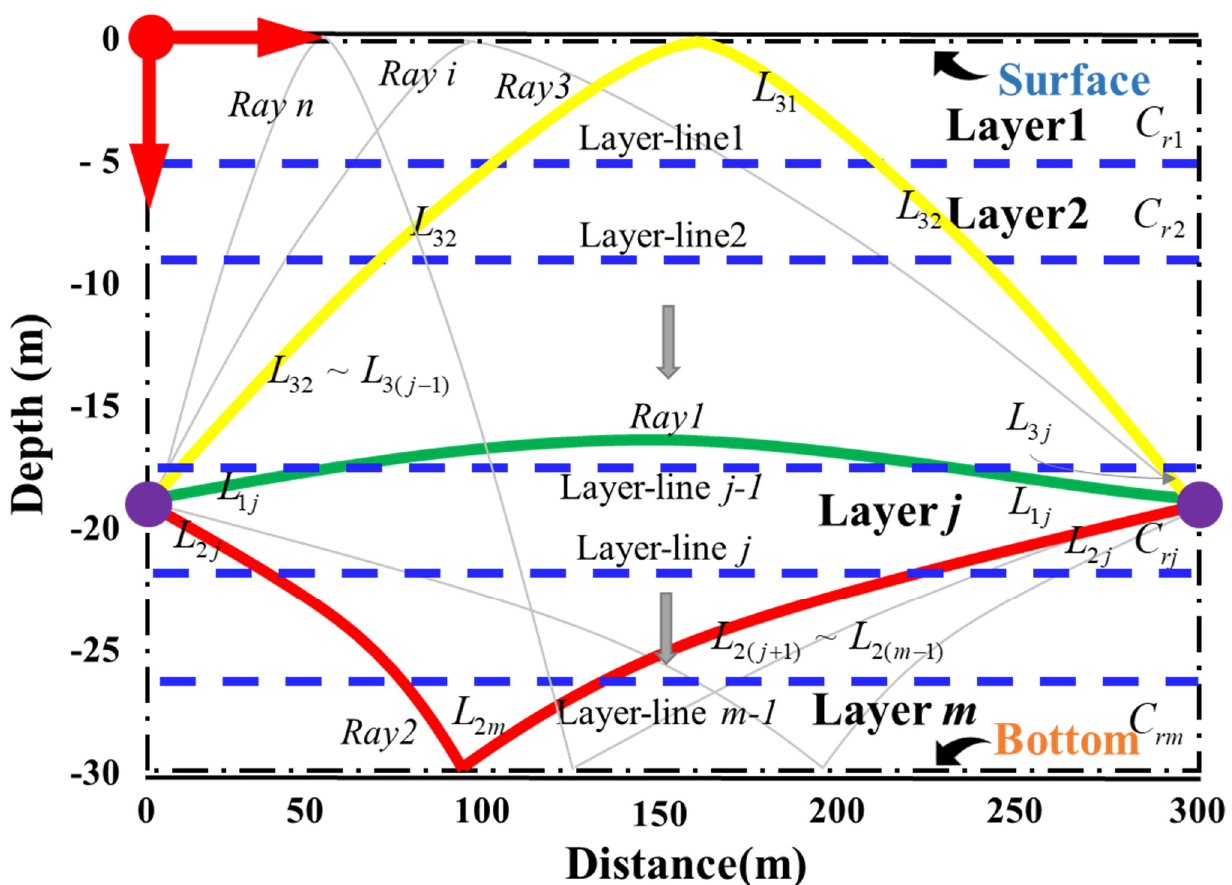
Figure 1. Reference ray simulation. L ij denotes the ray length of the i -th ray across the j -th layer. C rj denotes the reference acoustic speed of the j -th layer. The yellow line (Ray3) indicates a surface reflected ray. The green line (Ray1) indicates a direct ray. The red line (Ray3) indicates a bottom reflected ray. Gray lines are the sound ray that may exist but cannot be distinguished, which is not used for calculation. m denotes the total number of layers. n denotes the total number of rays.